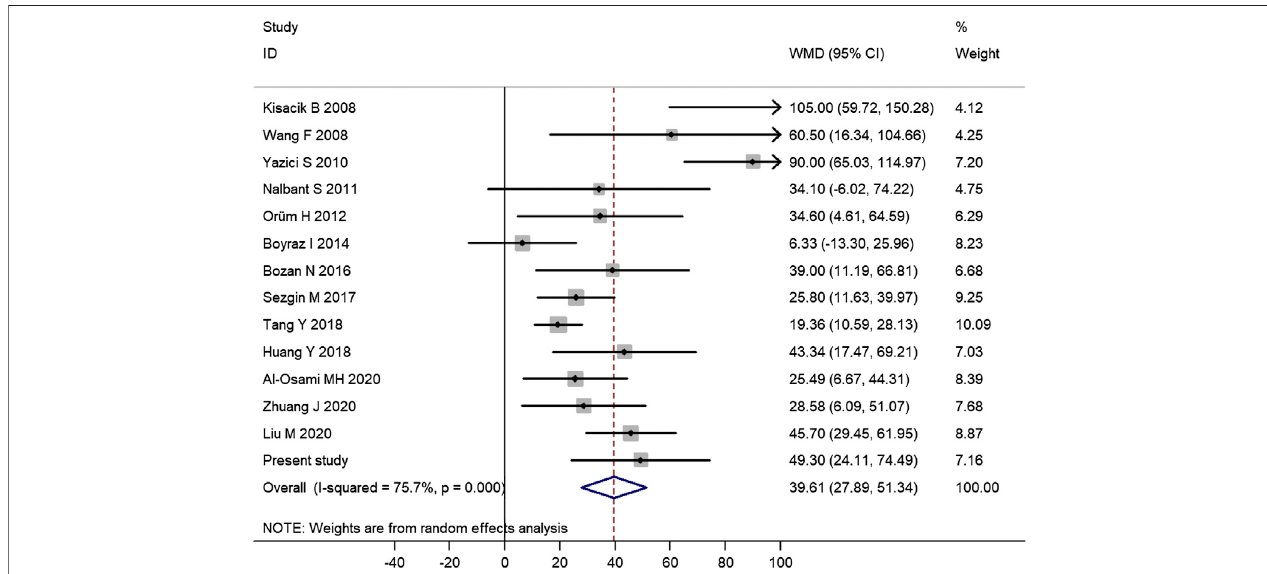
FIGURE 1 | Meta-analysis of 14 studies con fi rmed the signi fi cantly increased platelet count in AS patients. (WMD, weighted mean difference; 95% CI, 95% con fi denceinterval.BlackcirclerepresentstheWMDforeachstudy,andthesolidhorizontallineacrossthesquarerepresents95%CIforeachstudy.Thesizeofthegray box representstheweight for each study, and itisproportional tothesample sizeofeach study. Thediamond representsthepooled WMD, and its leftandright vertices represent the 95% CI.)